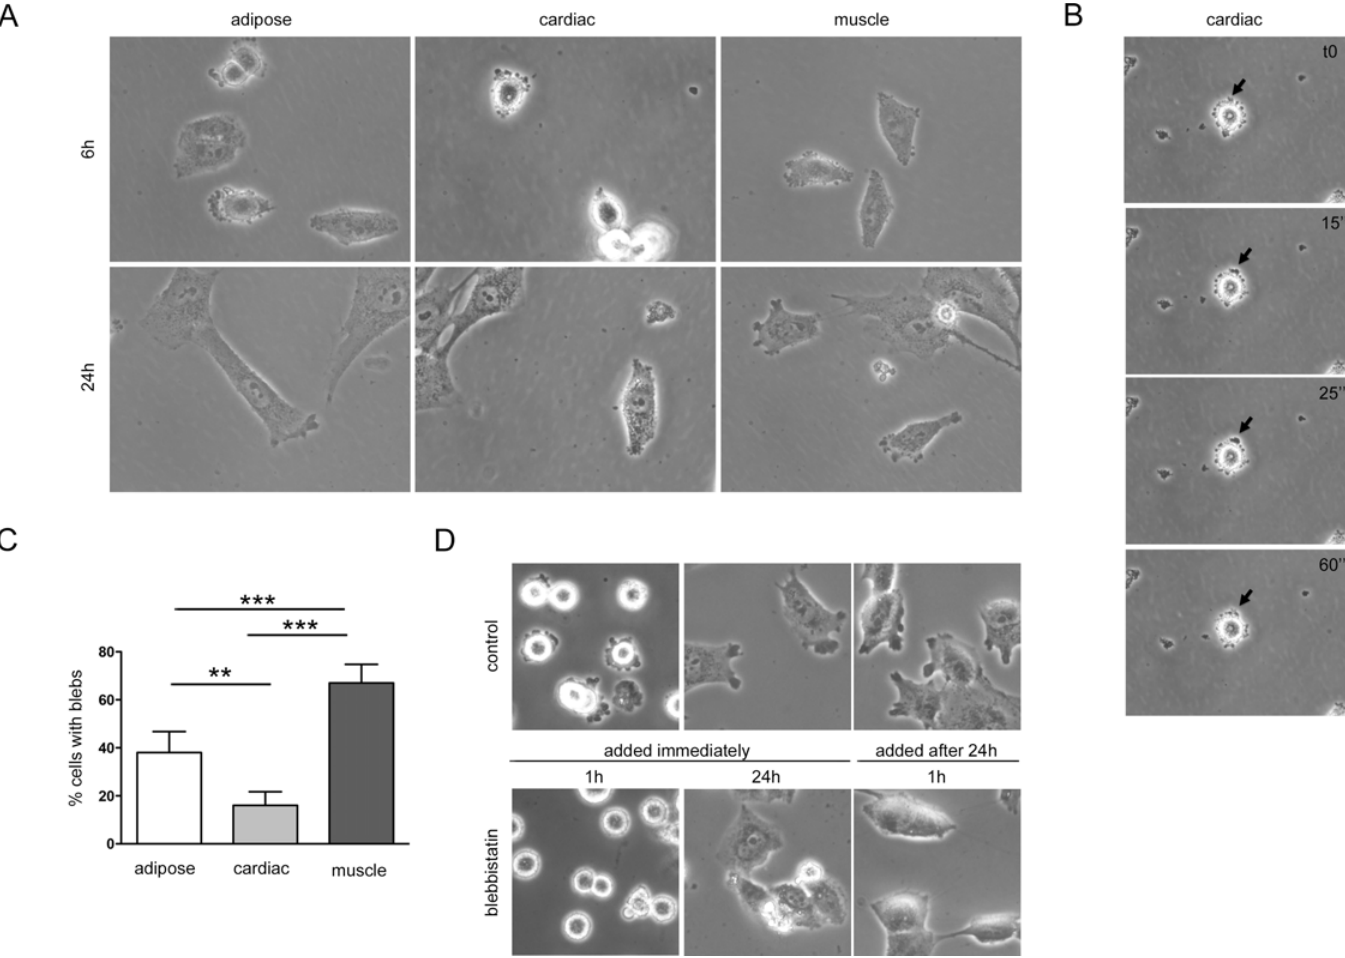
Fig 1. Morphological appearance of mesenchymal precursors in culture. (A) Representative phase contrast images (20x) of MPs at 6 and 24h in culture, where blebbing can be observed. (B) Time-lapse imaging of bleb formation (arrow) in a cardiac precursor, 6h after seeding. Images (20x) show bleb expansion (15 ” and 25 ” ) and bleb retraction (60 ” ). (C) Quantification of the percentage of cells with blebs in mesenchymal precursors; Statistical analysis were performed using Mann-Whitney test; ** P < 0.01; *** P < 0.001. (D) Blebbistatin-treated muscle precursors (magnification of 20x images), added at the same time of seeding and 24h later respect to control muscle precursors. Images were taken 1h and 24h hours after blebbistatin was